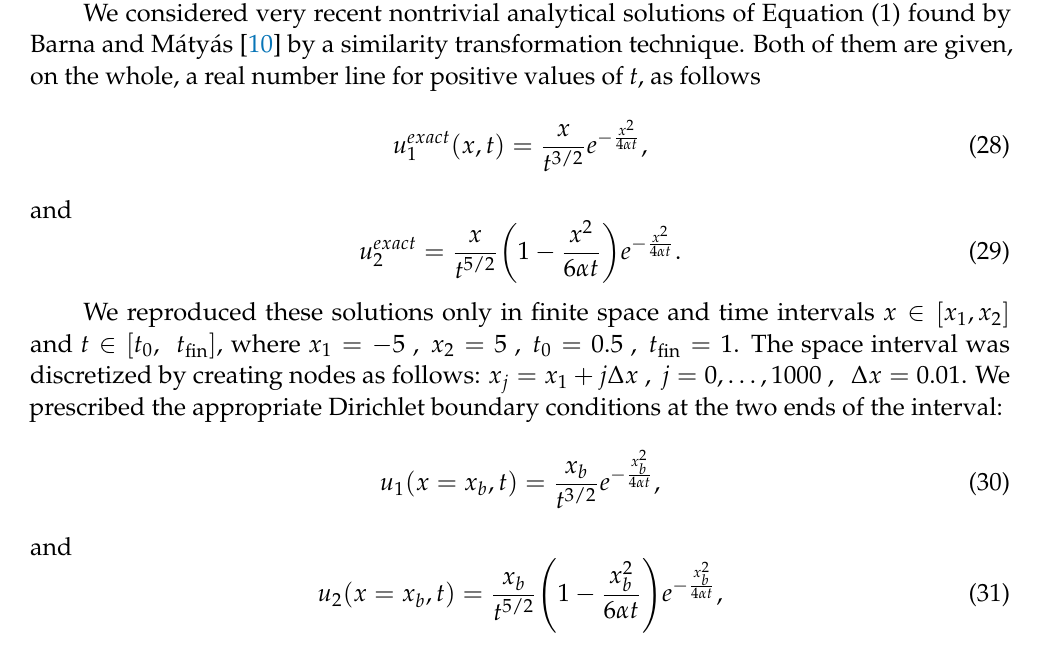
Figure 9. The graphs of the second solution, where u 0 is the initial function 2 and uref is the analytical solution at the final time, while S3 and S5 are the corresponding numerical solutions served by the S3 (¼, ½, ½, ½, ¾) and the S5 (0, ½, ½, C, 1) algorithms for